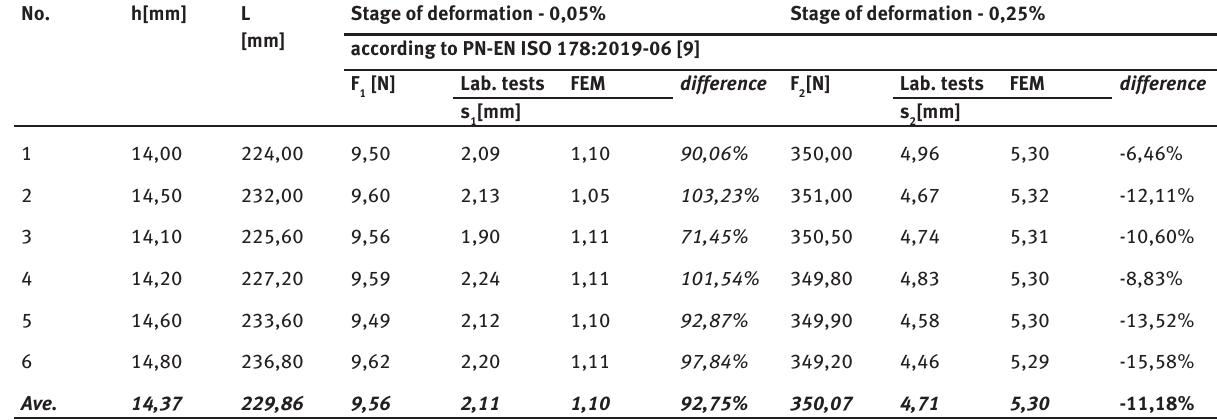
Table 12: Comparison of results of numerical analyses and laboratory tests for a model of a liner with a diameter of 500mm and 14,00mm wall